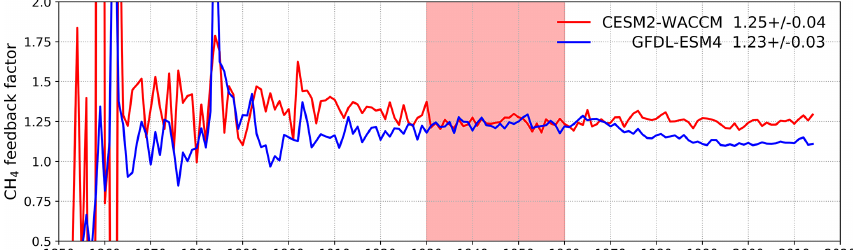
Figure 8. Calculated values for the methane–OH feedback factor ( f ) from the histSST-piNTCF experiments for CESM2-WACCM and GFDL-ESM4. Mean and standard deviation values for 1930–1960 (shaded time period) are